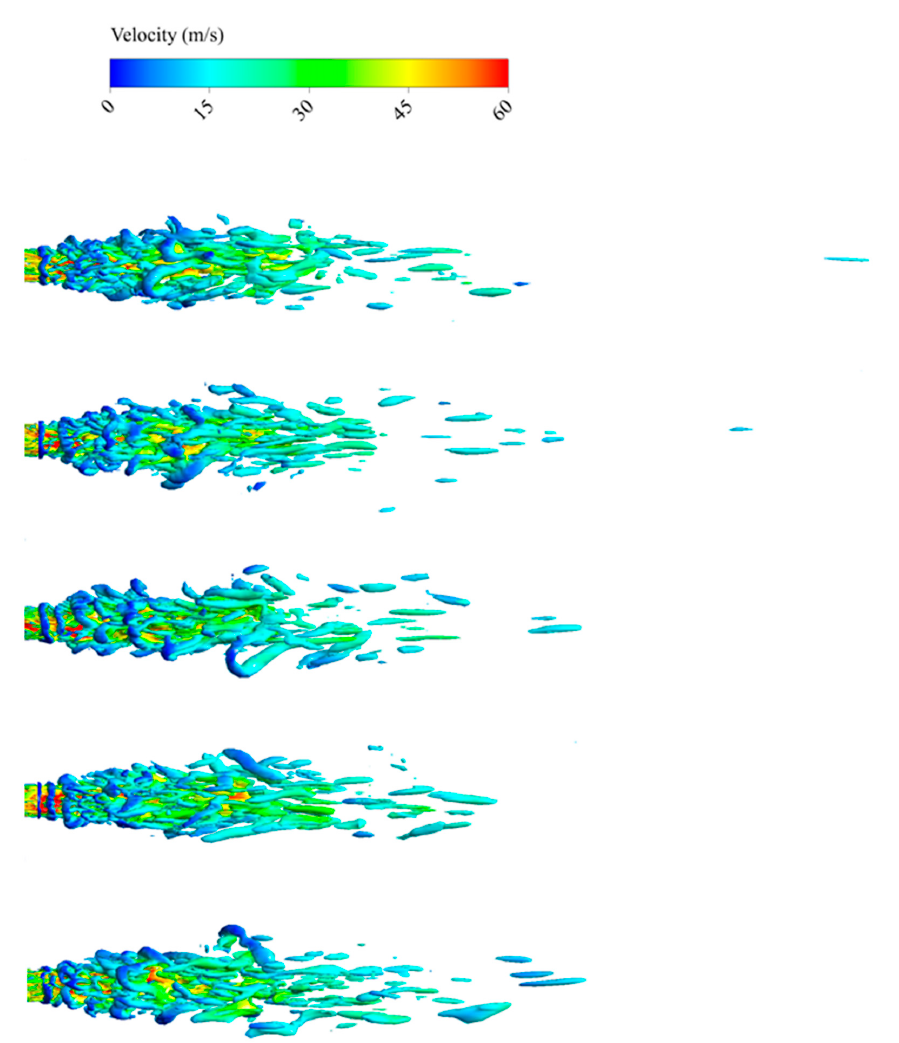
Figure 14. Vortex structure evolution over time ( Δ t = 5 ms, Q = 1 × 10 8 ).